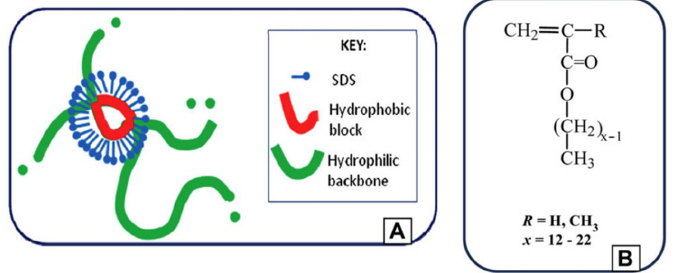
Figure 2. Self-healing gel ( A ) and the hydrophobic monomer ( B ). (Reprinted with the permission of Elsevier from [67]).